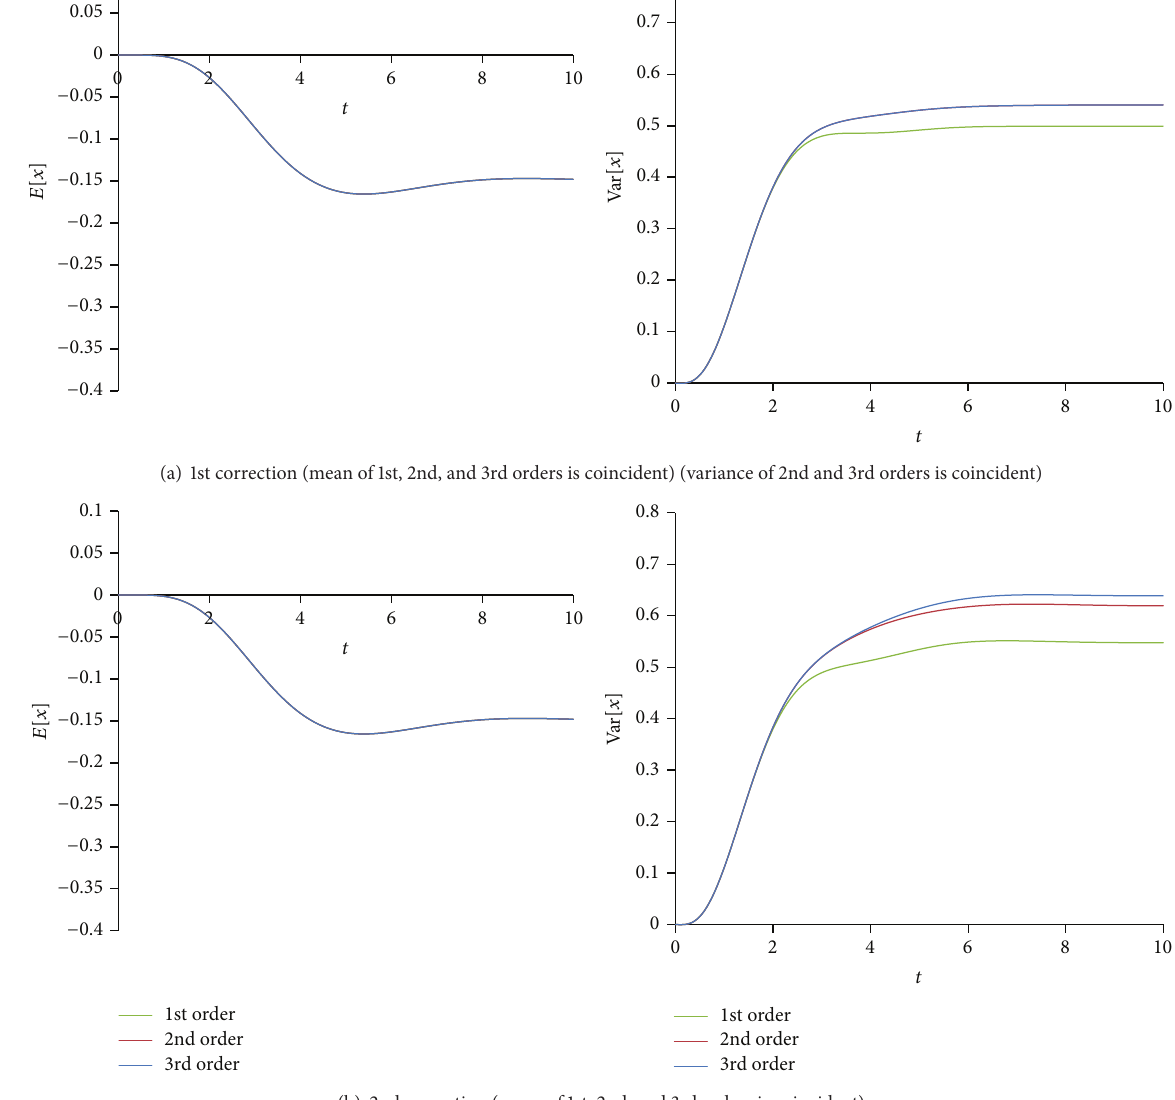
Figure 12: Comparison between the response mean and variance for the first, second, and third orders with number of corrections 1 and 2, 𝜀 = 0.3 .